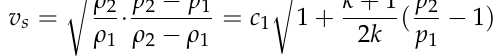
wave is, the maximum pressure behind the shock wave can reach 6 times the pressure before the shock